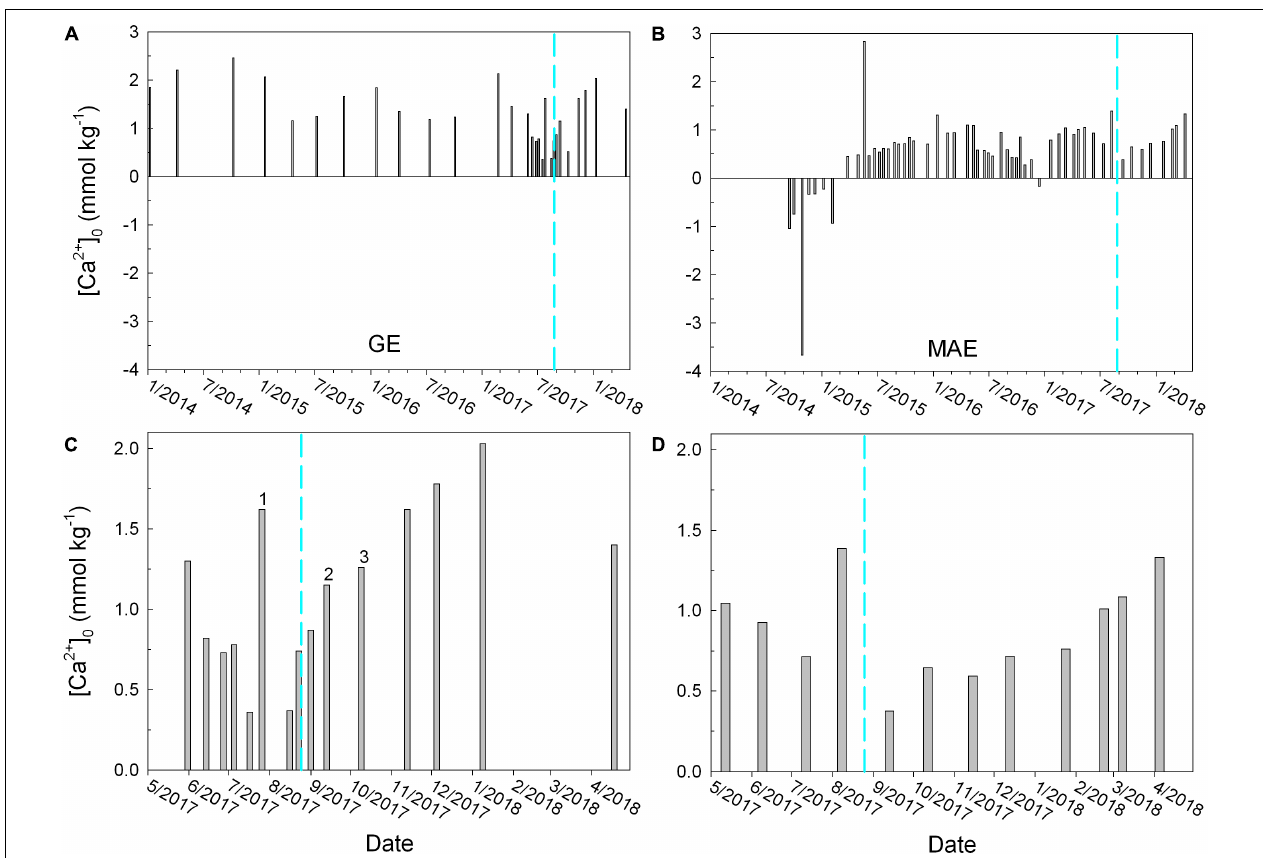
FIGURE 7 | Temporal changes in the intercept of [Ca 2 + ] and salinity regression (i.e., [Ca 2 + ] 0 ) in both GE (A) and MAE (B) . Panels (C) and (D) show the data during the period of May 2017 to April 2018 for these estuaries, respectively. Other than the marked [Ca 2 + ] 0 bars that have regressed r 2 values of 0.75 (#1, July 26), 0.80 (#2, September 13), and 0.95 (#3, October 9), all other r 2 values in (C) and (D) are better than 0.98. The lower r 2 values were all due to one data point that did not fall on each regression line possibly due to the significantly varying river endmember on the time scale of estuarine mixing (Cifuentes et al.,